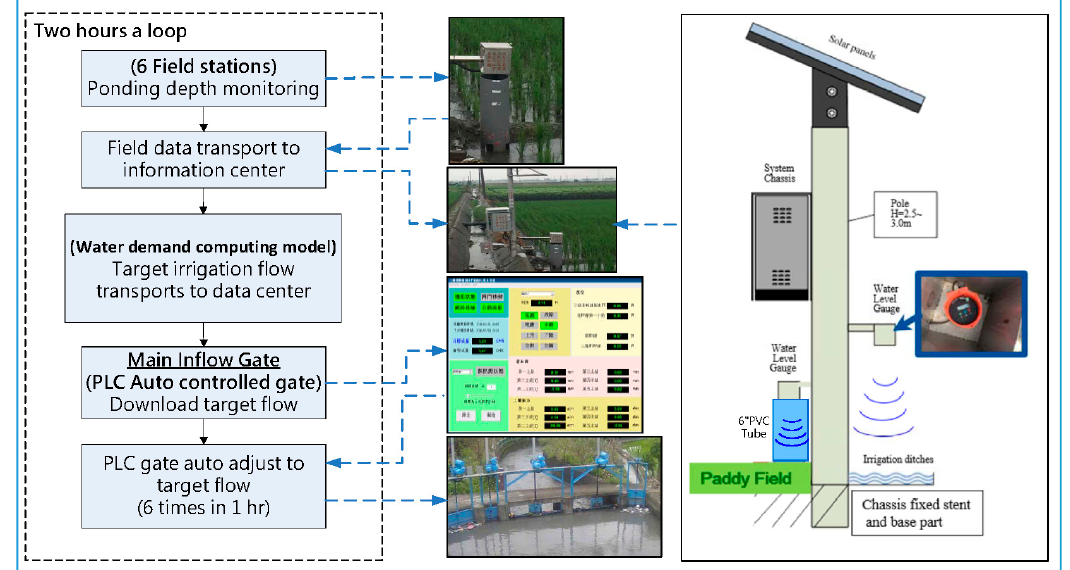
Figure 12. Scheme of information transmission and control of the field station.